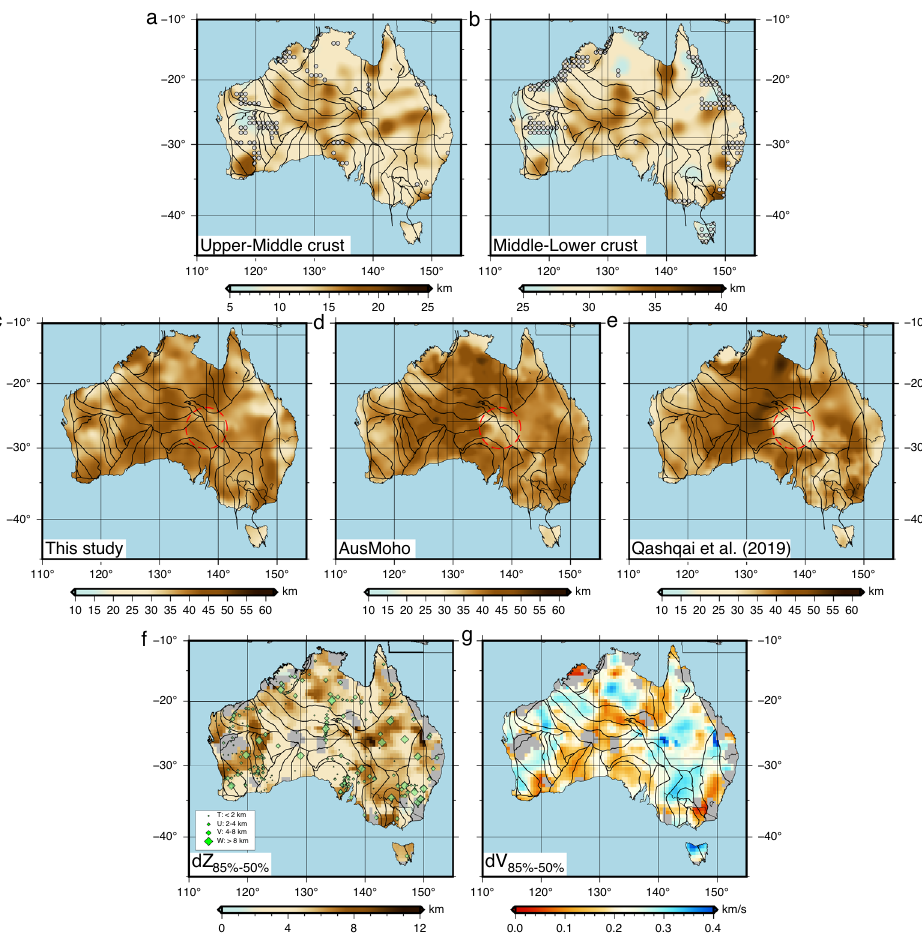
Fig. 9 | Crustallayering determinedfromthisstudyand previouswork. Crustal interfaces of a upper-middle crust and b middle-lower crust. The gray circles indicate the locations where the depth measurements are not reliable. Moho depths from c this study, d AusMoho 4 , and e P-wave coda auto-correlation imaging 36 . The data used in ref. 36 is recorded by a subset of stations used in this study. The most signi fi cant Moho depth difference among these models is high- lighted by the circle. f Transition thickness from the crust to the mantle. g The